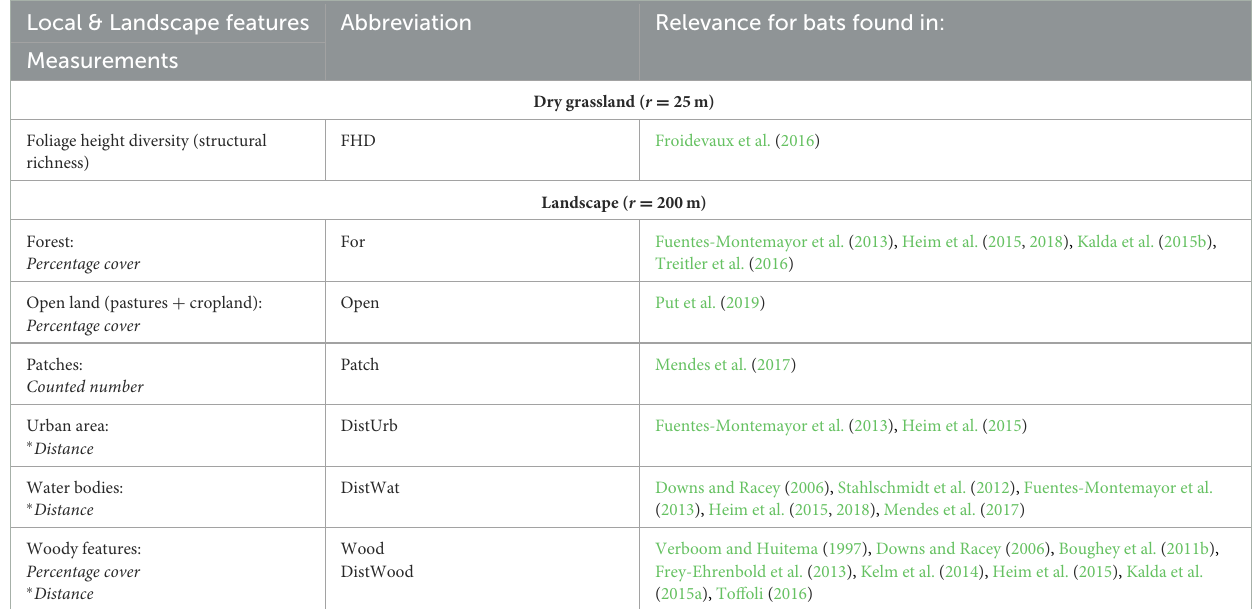
TABLE 1 Final choice of local and landscape features and their abbreviations used for further